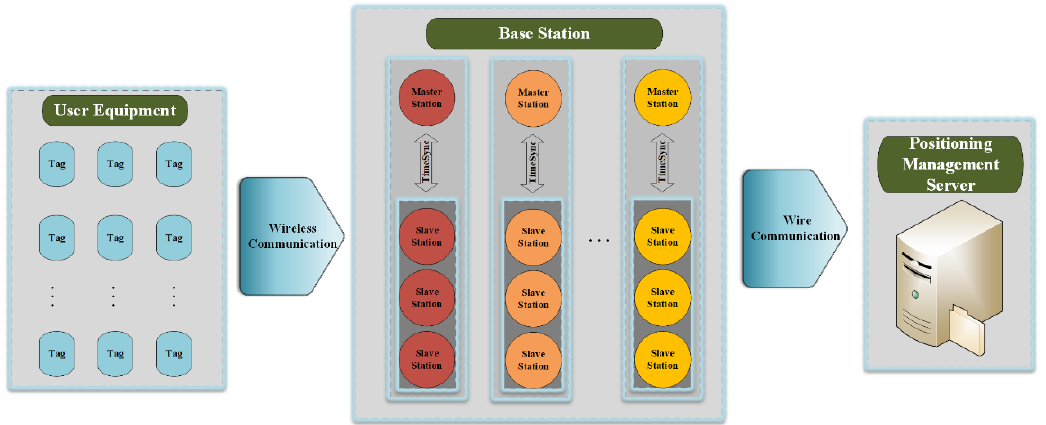
Figure 1. Ultra-Wideband (UWB) reverse positioning framework which contains three parts: user equipment (tags), base station (master stations and slave stations with time synchronized) and positioning management